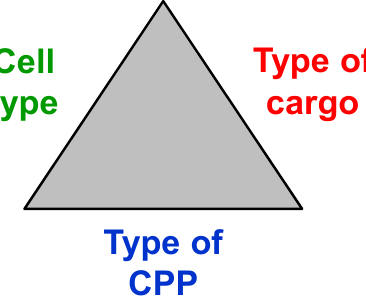
Figure 1. Relationships between Cells, Cargoes and CPPs. The scheme indicates the relationships between the different cell types, cargoes and CPPs. The conditions for each transduction task must be optimized